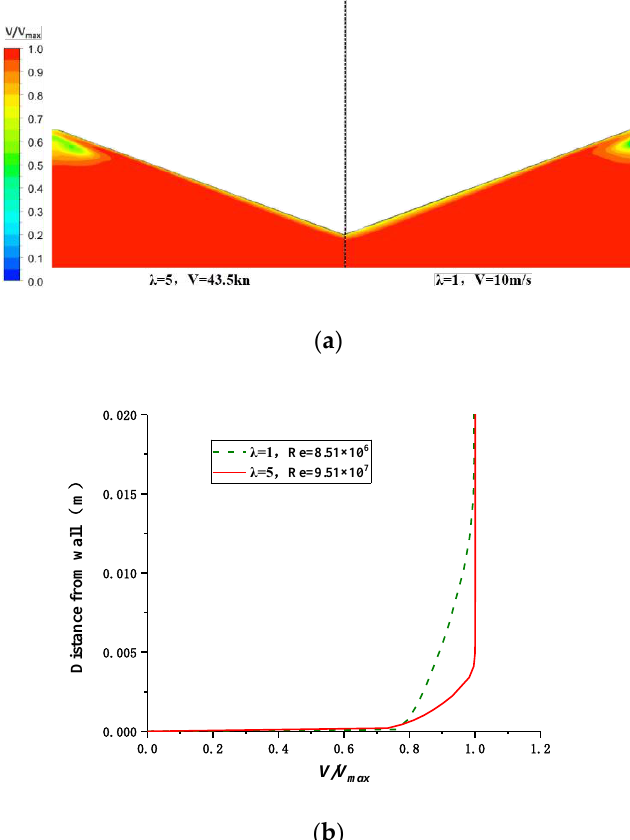
Figure 8. Velocity distribution in section of X/L = 0.4 and velocity versus distance from wall: ( a ) Velocity distribution in section of X/L = 0.4; ( b ) velocity versus distance from wall. And the mesh convergence studies are carried out at the volume-based Froude numbers of 2.29, 4.58, and 6.87. Four sets mesh of sizes, named as Grid1–Grid4, are investigated, the original size and three others with mesh fineness √2 , 2 and 2√2 respectively. The total numbers of the meshes are